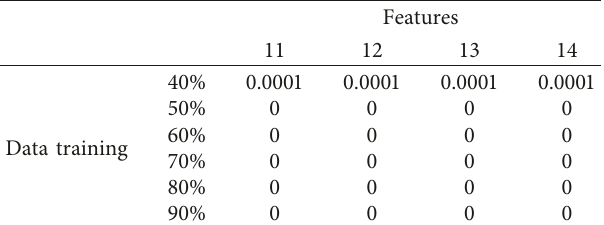
Table 4: PSO-SVR NMSE values of Agung Podomoro Land Tbk